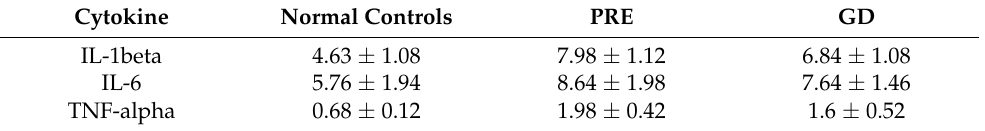
Table 3. Inflammatory Cytokines are found in Homogenates of Umbilical VSMC taken from